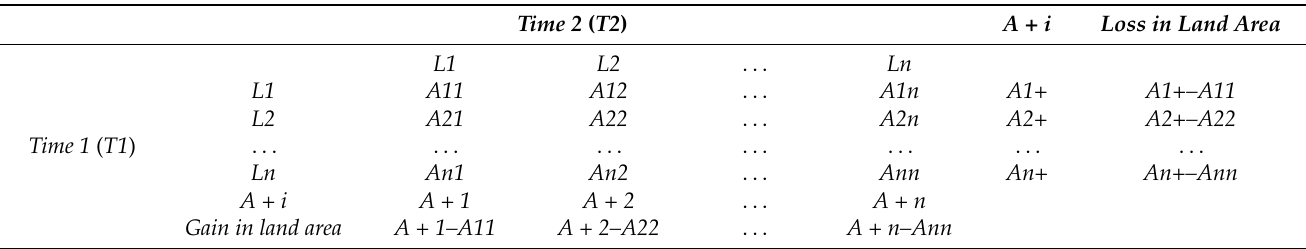
Table 2. A sample transfer matrix of land use change